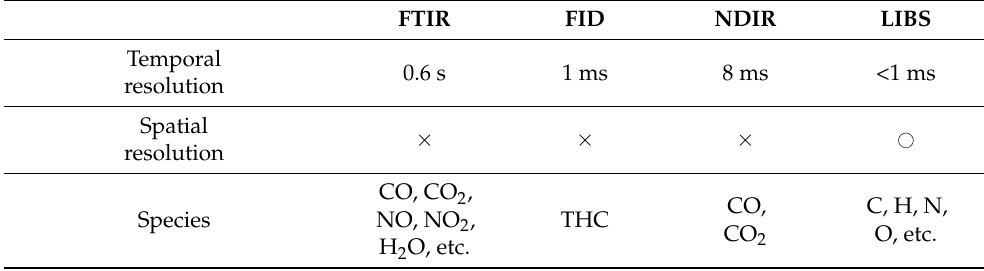
Table 1. Comparison of gas species measurement